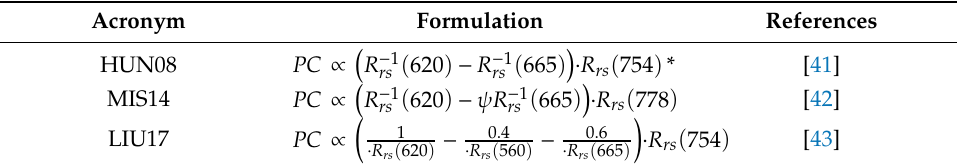
Table 1. Semi-empirical algorithms for remote estimation of